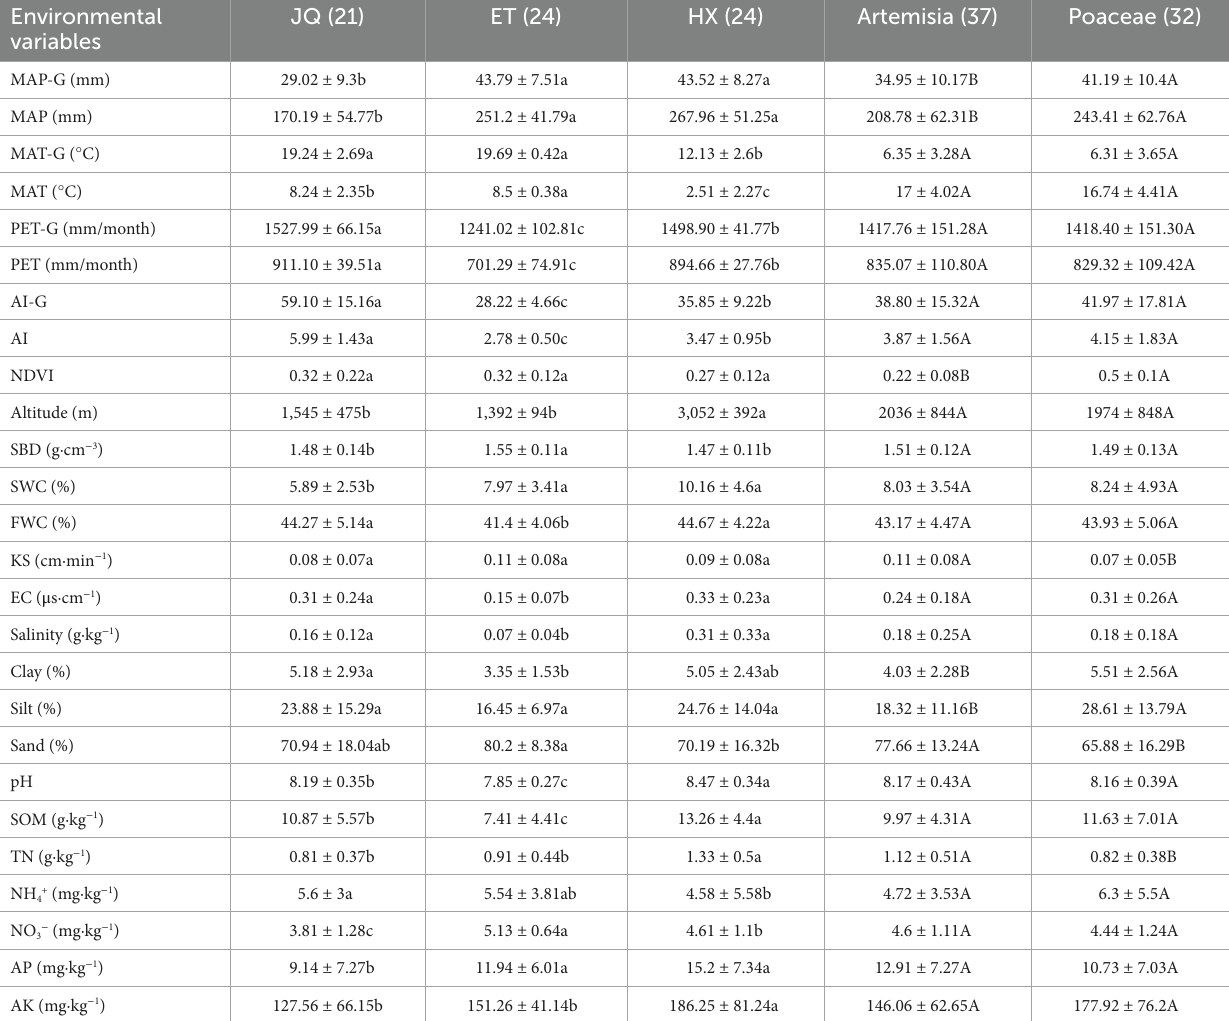
TABLE 1 The environmental variations across three regions and two habitats. Environmental